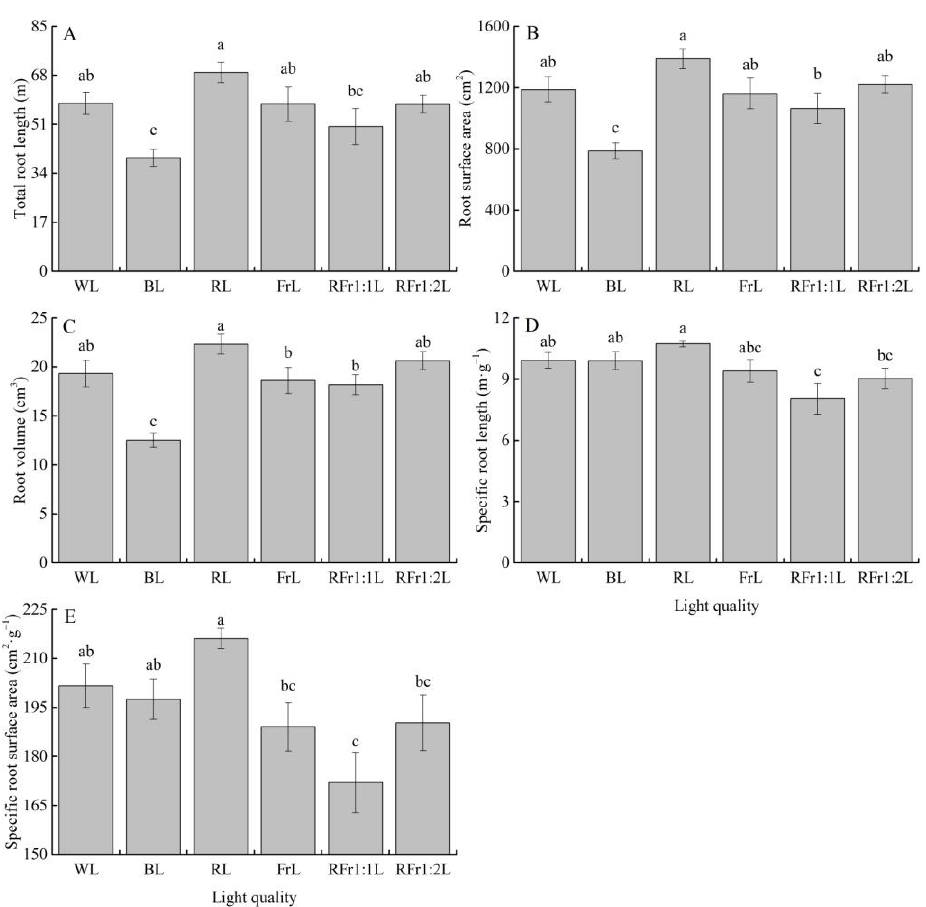
Figure 3. Total root length ( A ), root surface area ( B ), root volume ( C ), specific root length ( D ), and specific root surface area ( E ) of Cunninghamia lanceolata seedlings under different light quality treatments. Bars represent average ± standard error ( n = 6). Different lowercase letters indicate significant differences among treatments.